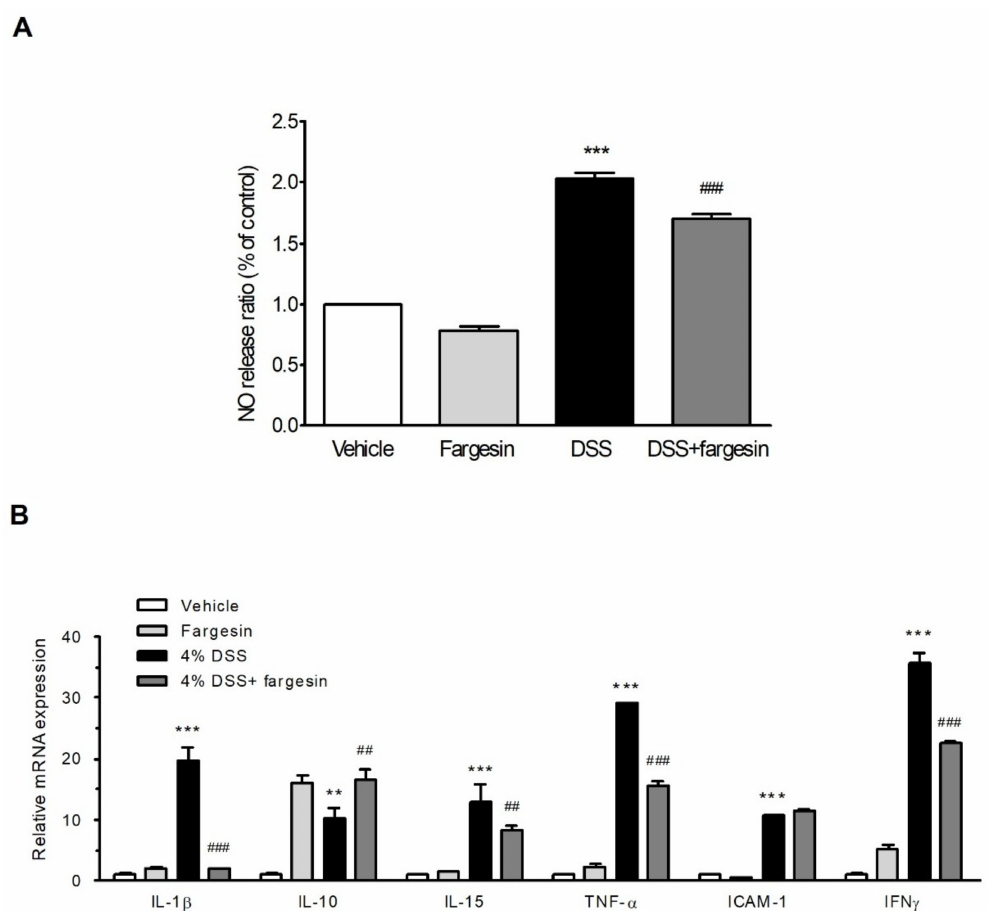
Figure 3. Fargesin downregulated NO production and proinflammatory mediator gene expression in vivo. ( A ) Serum NO level was measured as described in the Methods. Data were expressed as mean ± SD ( n = 6); ( B ) mRNA expression of proinflammatory genes was determined by qRT-PCR in colon samples. Expression value was normalized to β -actin and each bar represented the mean ± SD of two independent experiments with samples in triplicate. ** p < 0.01, *** p < 0.001 vs. vehicle-treated group; ## p < 0.01, ### p < 0.001 vs. DSS-treated